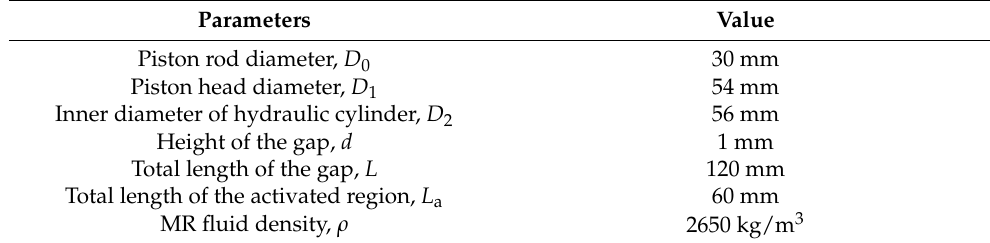
Figure 7. Drop-weight impact test system: ( a ) schematic and ( b ) picture. Table 1. Main parameters of the